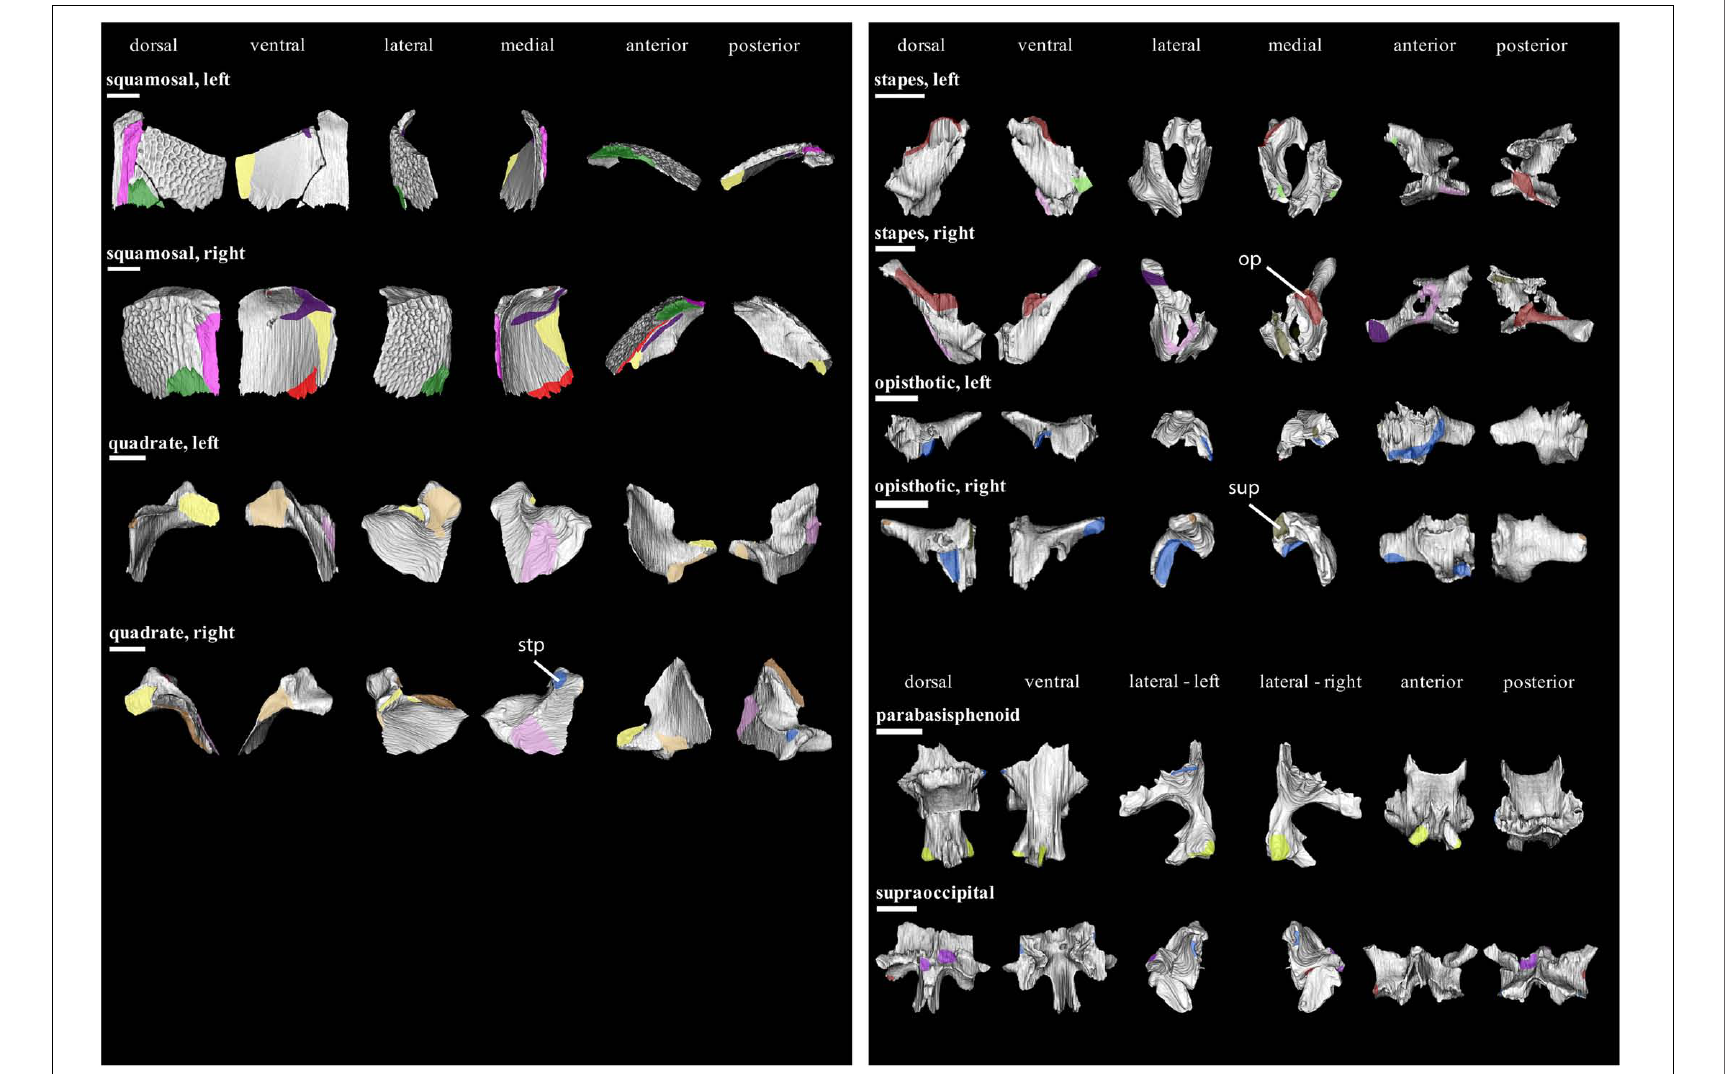
FIGURE 9 | Isolated bones in dorsal, ventral, lateral, medial, anterior and posterior views. Articulation areas with other bones are colored. Left and right squamosal, Left and right quadrate, Left and right stapes, Left and right opisthotic, parabasisphenoid, and supraoccipital are shown. Scale bar = 10 mm. For abbreviations see caption to Figure 1